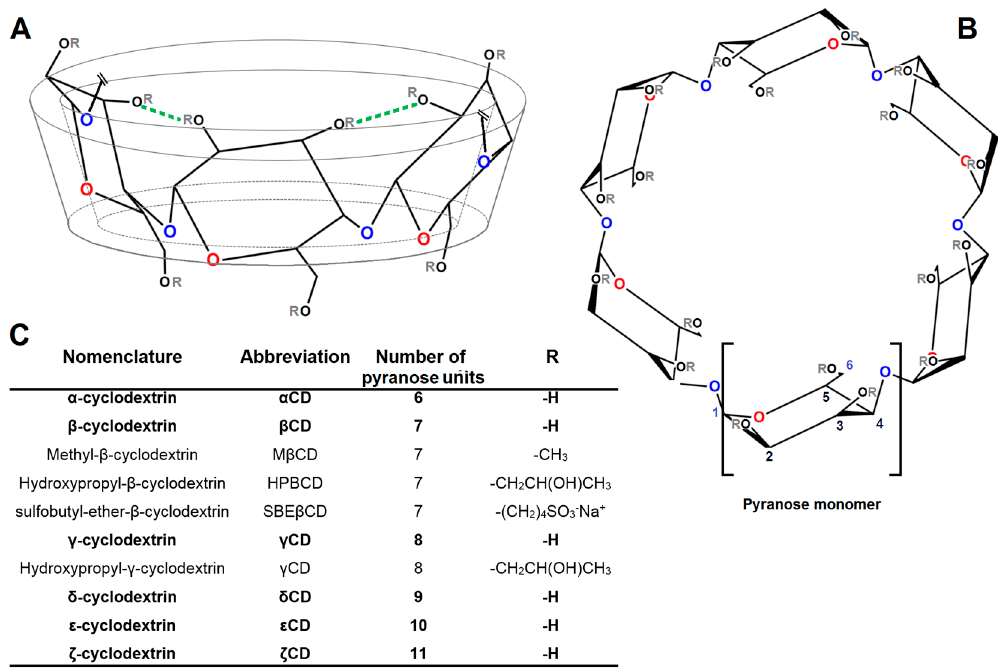
Figure 1. Front side prospect ( A ); top prospect ( B ); nomenclature and chemical characteristics ( C ) of most common cyclodextrins. The blue oxygens represent the etheric bonds 1–4 (inter-monomeric bonds), whereas, the red oxygens represents pyranose ether bonds 1–5 (intra-monomeric bonds). The green lines represent the intramolecular H-bonds forming in β CD when no substituent groups are present (R: -H). Table 1. Some physicochemical properties of the most relevant CDs ( α -, β -, and γ CD) at 25 ◦